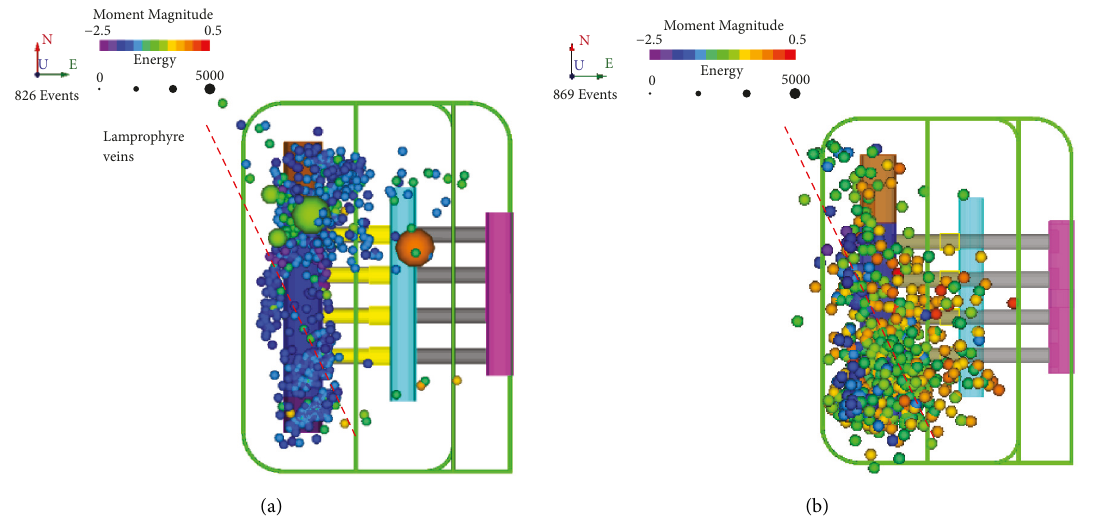
Figure 14: Spatial distribution of microseismic events in the main powerhouse. (a) In 2018. (b) In 2019. DensityUN Contouring: Event E